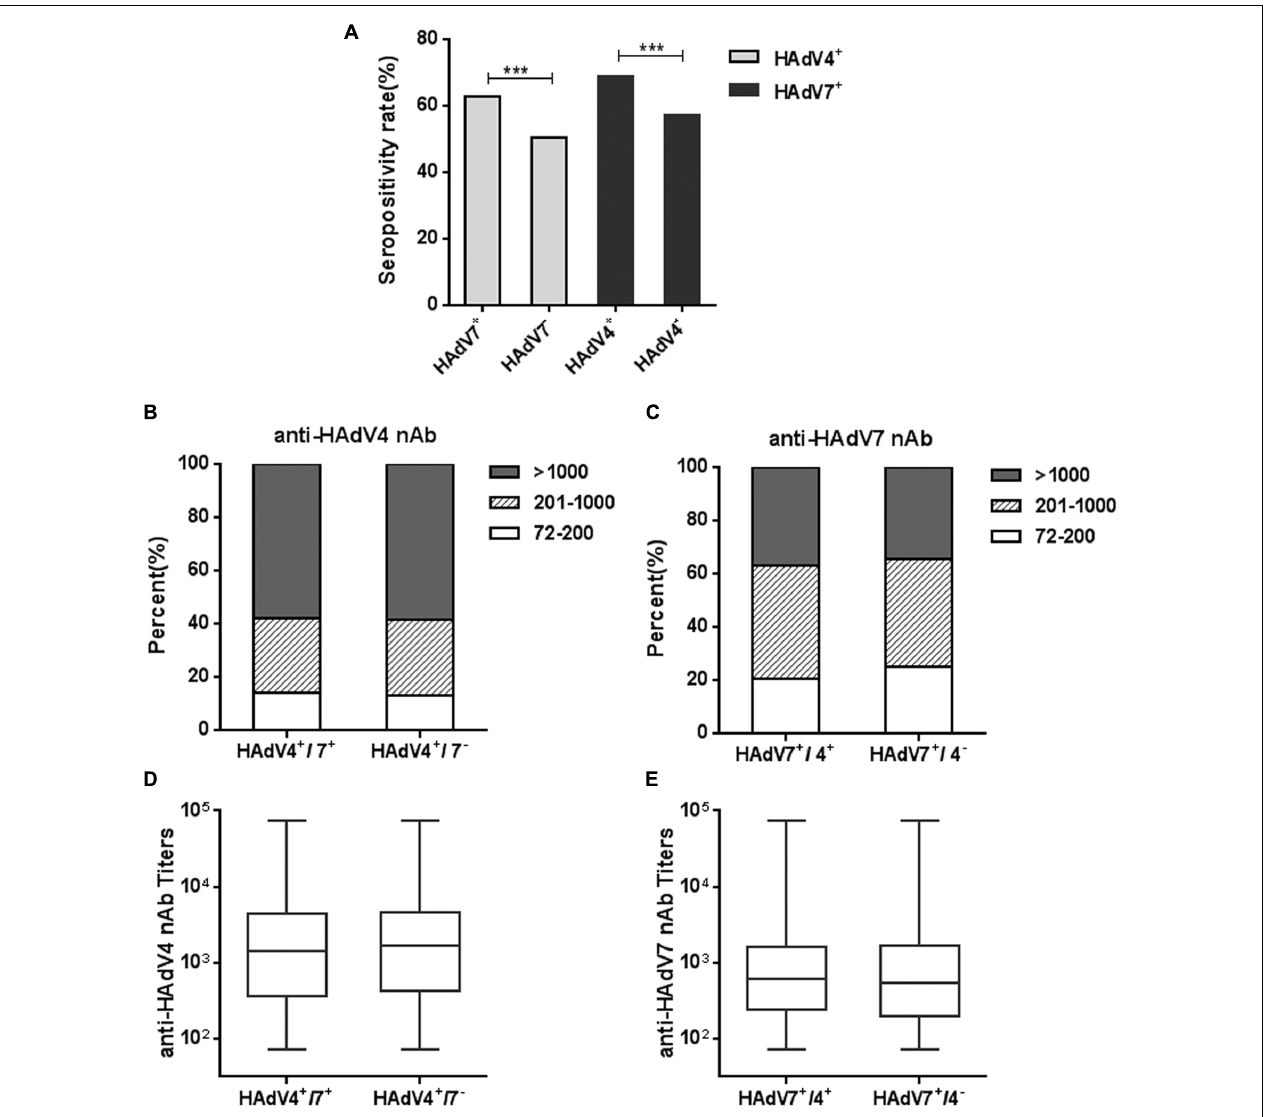
FIGURE 5 | Seropositivity rates and titers of anti-HAdV4 nAb and anti-HAdV7 nAbs in single- and double-positive samples. (A) The seropositivity rates of anti-HAdV4 nAb and anti-HAdV7 nAb in single-positive and double-positive serum samples. The data were analyzed with Chi-square test. ∗∗∗ P < 0.001. (B,C) The distributions of anti-HAdV4 nAb (B) and anti-HAdV7 nAb (C) titers in single-positive and double-positive serum samples. (D,E) Overall titers of anti-HAdV4 nAb (D) and anti-HAdV7 nAb (E) in single-positive and double-positive serum samples. The data were analyzed using the Mann-Whitney